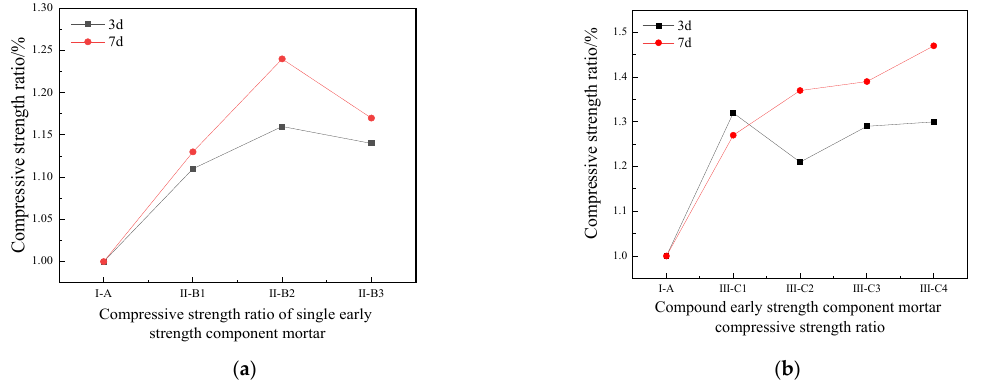
Figure 2. Effect of SAP on the early-age compressive strength ratio of mortar: ( a ) single early-age strength component; ( b ) compound early-age strength components.